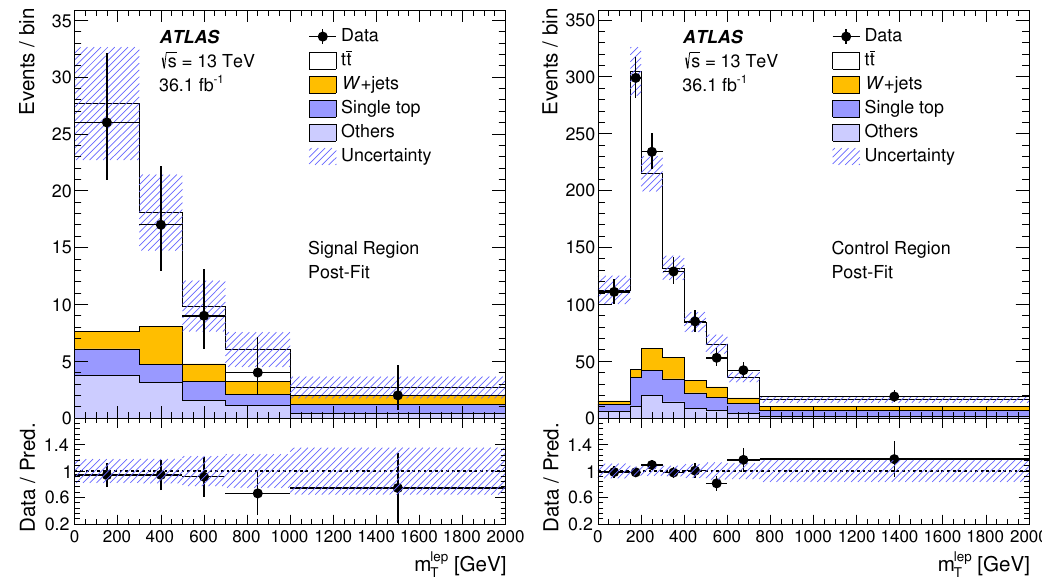
Figure 3 . Fit results (background-only) for the leptonic VLQ candidate mass distributions ( m lep in (left) the signal region and (right) the control region. The lower panel shows the ratio of data to the (cid:12)tted background yields. The band represents the systematic uncertainty after the maximum- likelihood